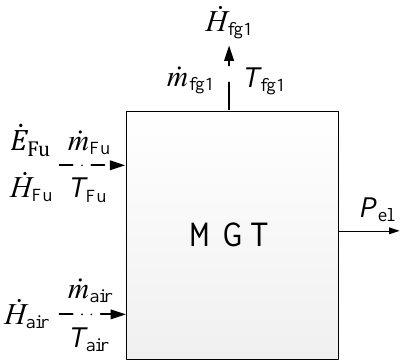
Figure 2. Black box MGT model which is an abstraction of the MGT shown in Figure 1.